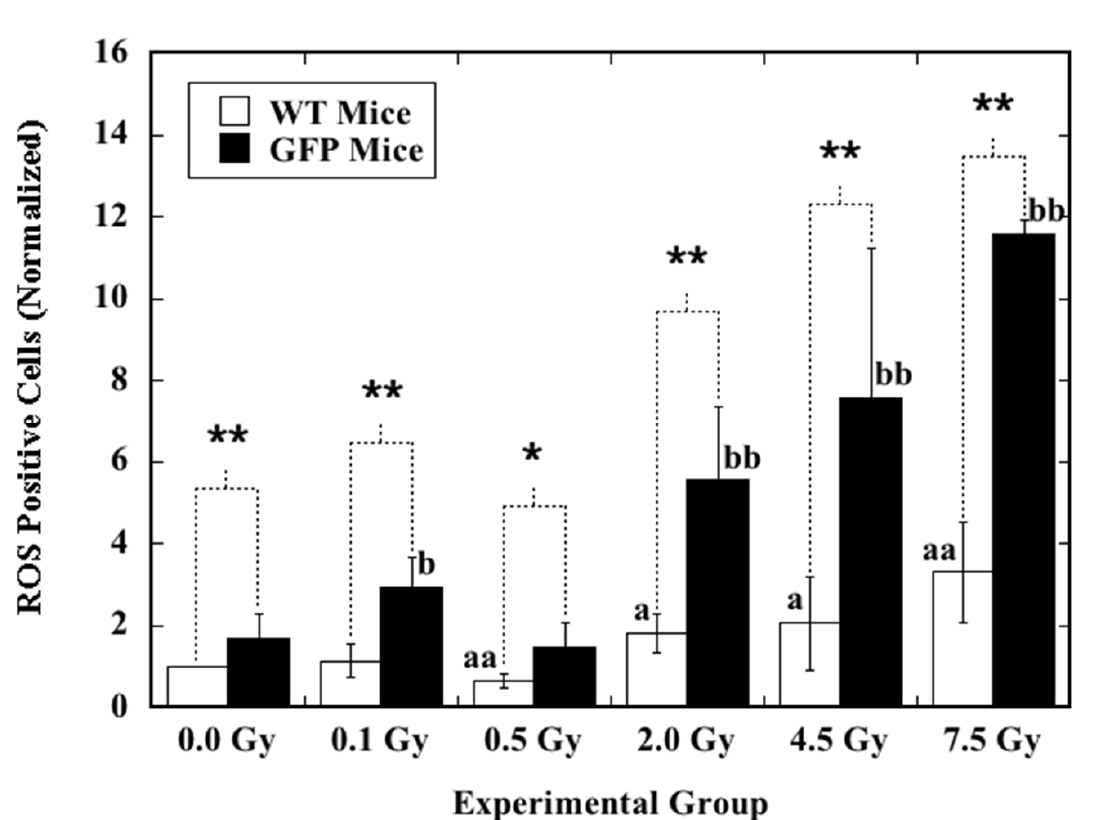
Figure 1. Induction of ROS by ex vivo X-irradiation in hematopoietic cells from mice at eight postnatal weeks. Nucleated bone marrow cells were irradiated (0.1–7.5 Gy) or sham-irradiated (0.0 Gy) with X-rays, and induction of ROS was measured. Data are presented as ratios normalized to the ROS results of the cells from sham-irradiated control WT mice. One (*) and two asterisks (**) indicate statistically significant differences (* p < 0.05; ** p < 0.01) between the two groups that were compared. For comparison of the irradiated group to the sham-irradiated control in WT mice, one letter “a” and two letters “aa” stand for statistically significant differences at p < 0.05 and p < 0.01, respectively. For comparison of the irradiated group to the sham-irradiated control in GFP mice, one letter “b” and two letters “bb” stand for statistically significant differences at p < 0.05 and p < 0.01, respectively.